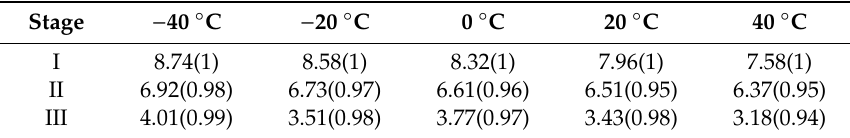
Table 8. Three-stage slope linear fitting of stress-strain